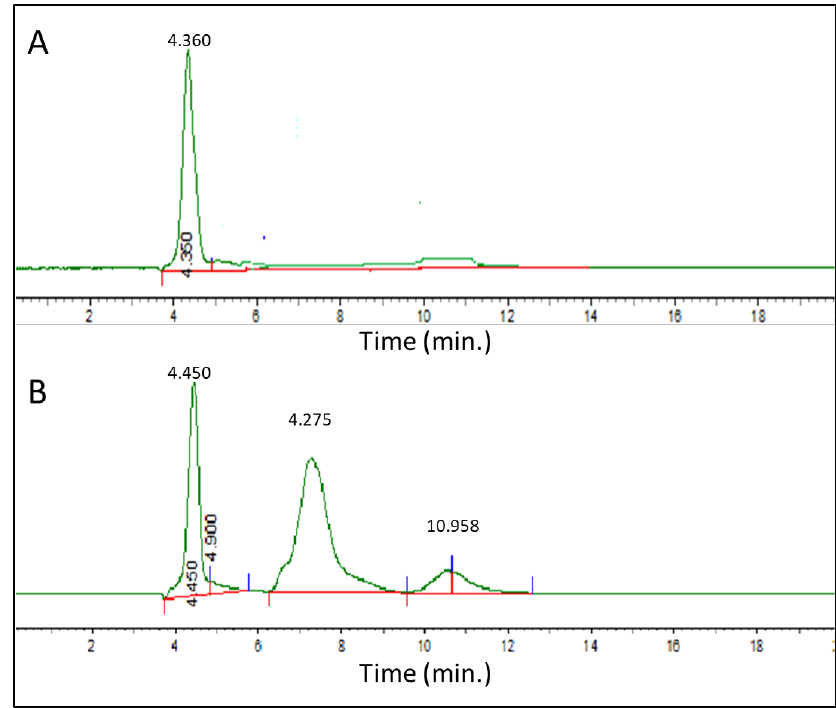
Figure 3. HPLC analysis of LEPN. Representative HPLC chromatograms of ( A ) standard phyllanthin, showing a peak at the retention time of 4.36 min, and ( B ) leaf extract of P. niruri , displaying a peak at the retention time of 4.450 min, with two additional peaks at 7.275 min and 10.958 min.